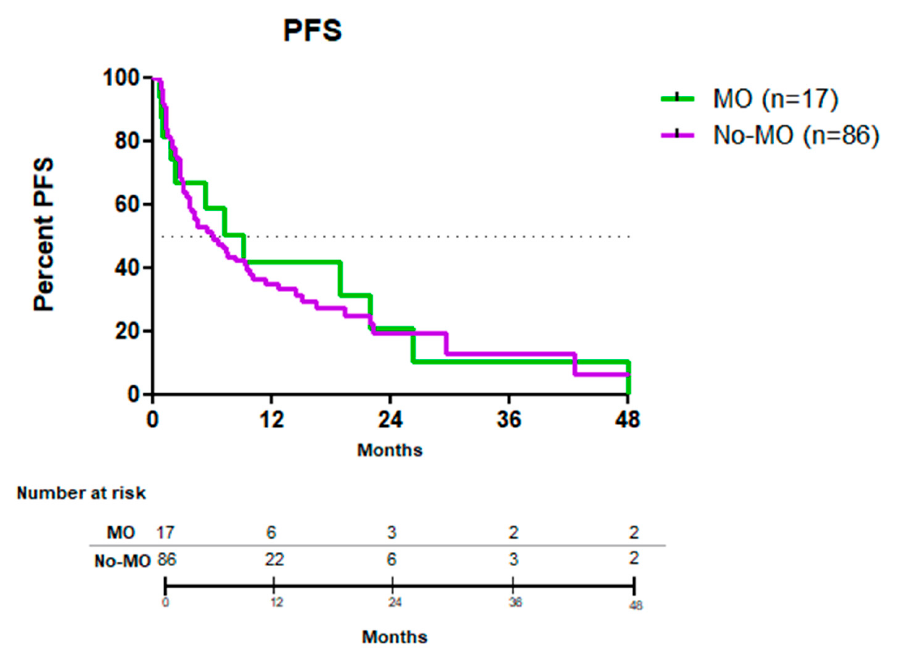
Figure 6. Kaplan–Meier plots of overall survival and progression-free survival by MO and no-MO treatments in patients with relapsed or refractory MM included in the MM-EP1 study. MO: molec- ularly-oriented, No-MO: not molecularly oriented, OS: overall survival, PFS: progression-free sur- vival, MM: multiple